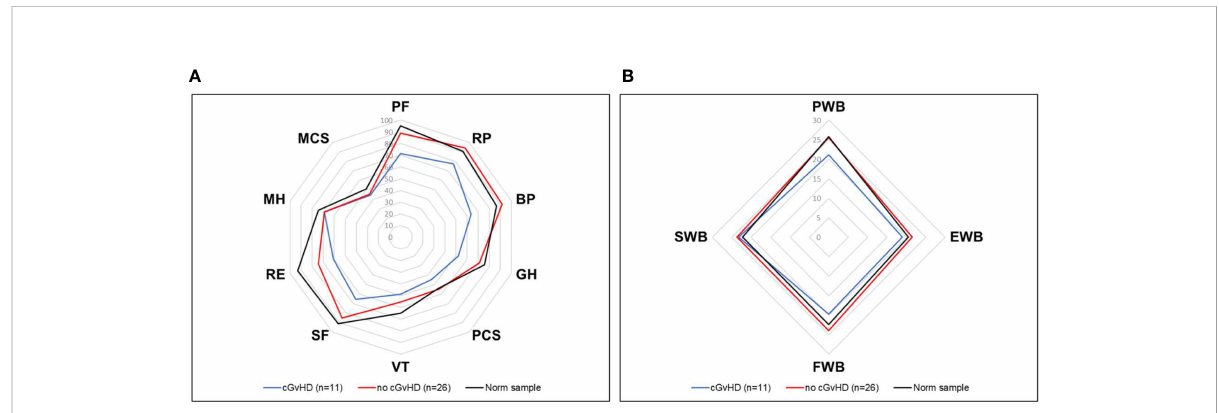
FIGURE 6 HRQOL of generalized norm cohort (n=576, black line) and transplanted pediatric CML patients with (n=11, blue line) and without (n=26, red line) cGvHD. (A) The SF-36 questionnaire includes the physical health (PF), role physical (RP), bodily pain (BP), general health (GH), physical component summary score (PCS), vitality (VT), social functioning (SF), role emotional functioning (RE), mental health (MH) and mental component summary score (MCS) subscales. (B) The FACT-BMT questionnaire consists of the 4 main dimensions physical well-being (PWB), emotional well-being (EWB), functional well-being (FWB), and social well-being